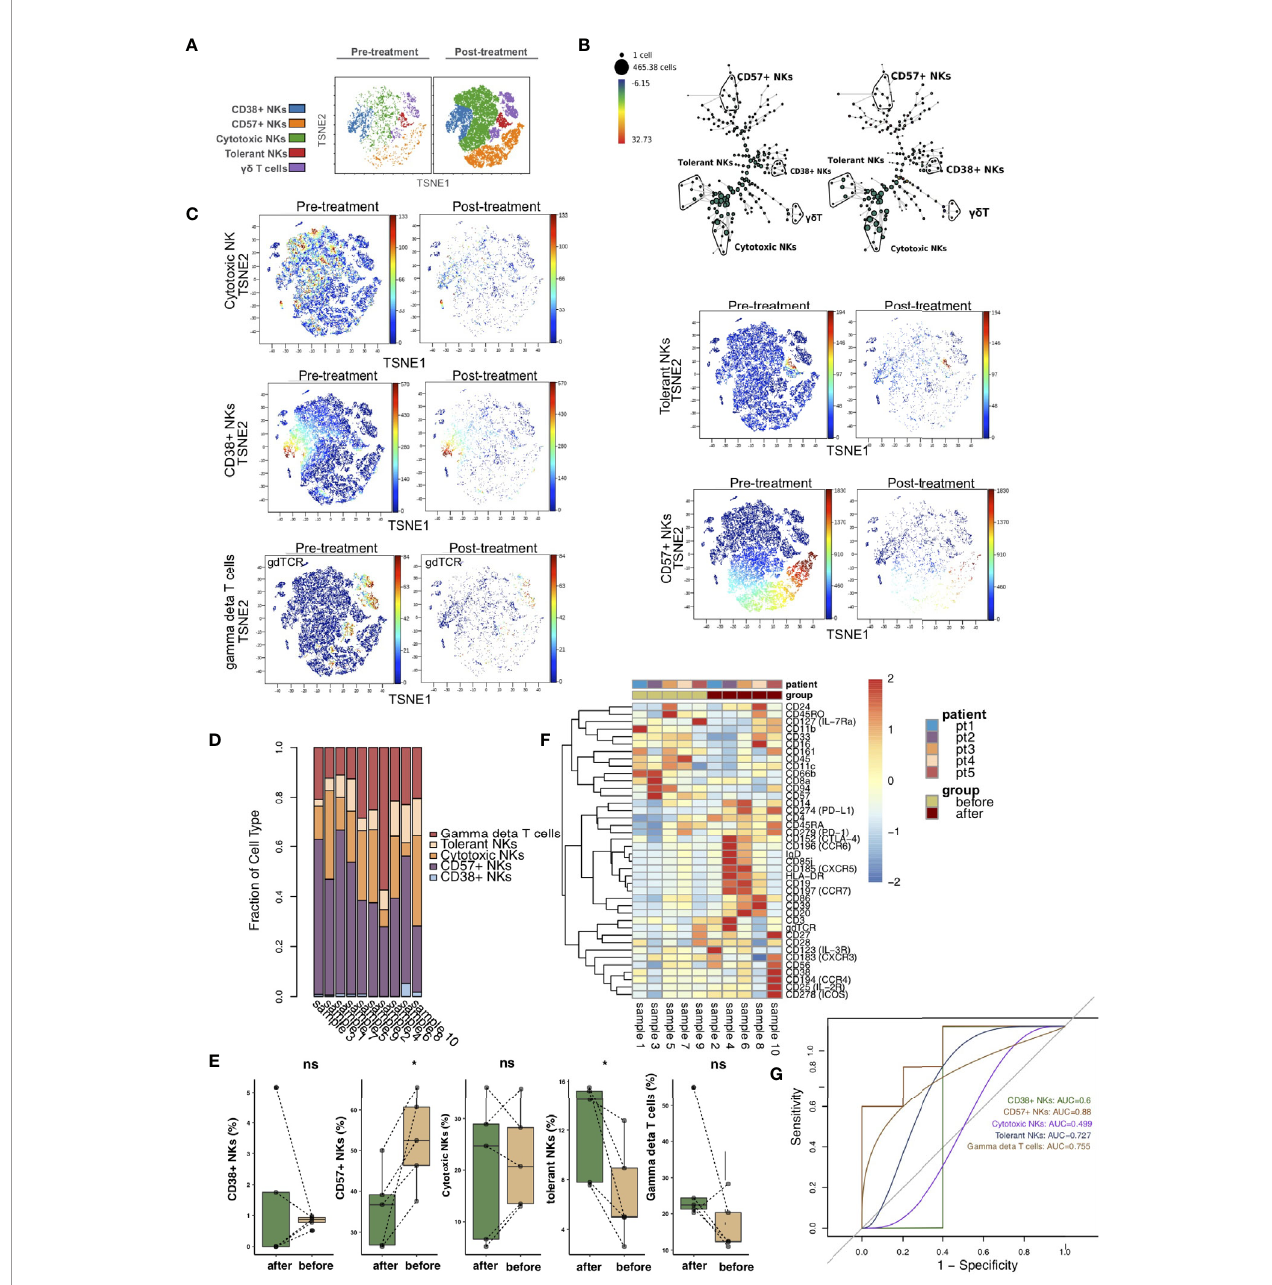
FIGURE 4 | NK cell/ gd T cell subclusters in the kidney. (A) t-SNE plots of CD38+ NK cells, CD57+ NK cells, cytotoxic NK cells, tolerant NK cells and gd T cells. (B) In SPADE trees, node color is scaled to the fold change in gdTCR content, and node size is scaled to the number of cells. (C) t-SNE plots of gdTCR, CD38, CD57, CD56 and CD11b expression in the pre- and posttreatment groups. (D) The proportions of NK cell/ gd T cell subclusters in all samples. (E) Comparison of the proportion of NK cell/ gd T cell subclusters between the pre- and posttreatment groups. (F) Heatmap of the marker expression of NK cells/ gd T cells for all samples. (G) ROC curve of NK cell/ gd T cell subclusters predicting the pre- and posttreatment groups. *P < 0.05; ns, not signi fi